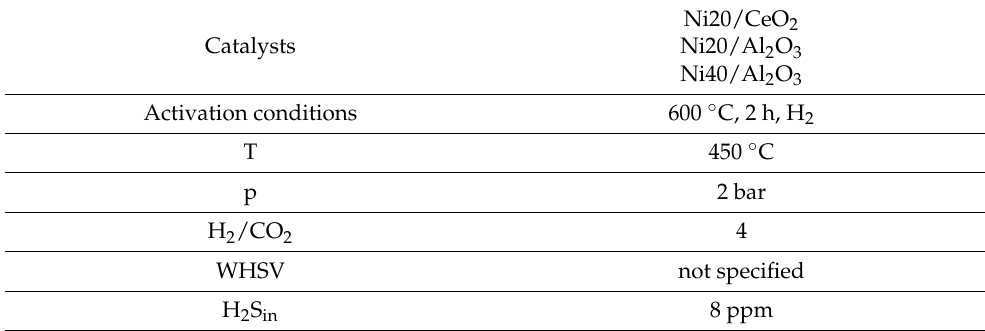
Table 12. Catalysts and reaction conditions for experiments on H 2 S influence on methanation with unpromoted Ni catalysts in a fixed-bed reactor